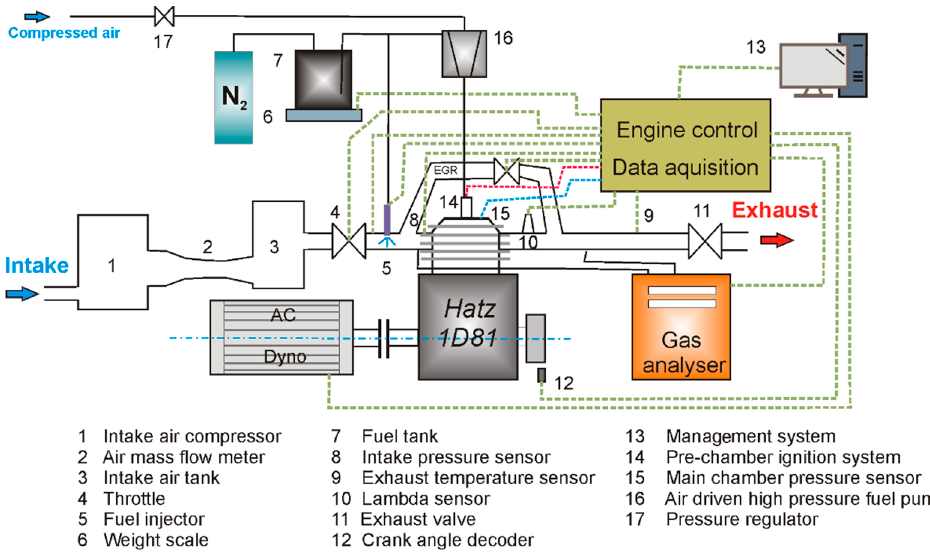
Figure 1. Layout of experimental setup.